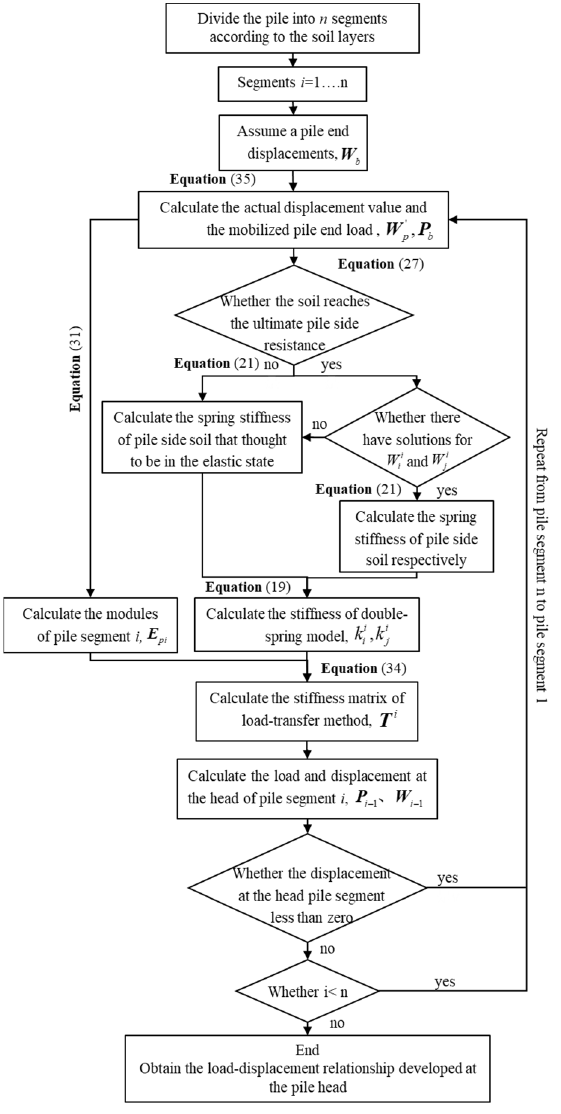
Figure 6. Computational flow chart for the response of group piles.